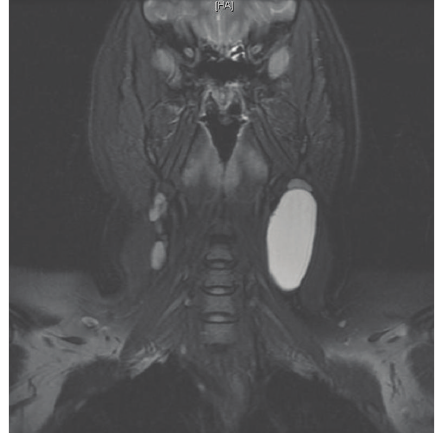
Figure 3: MRI-coronal view showing the cystic lesion with high T2 signal.